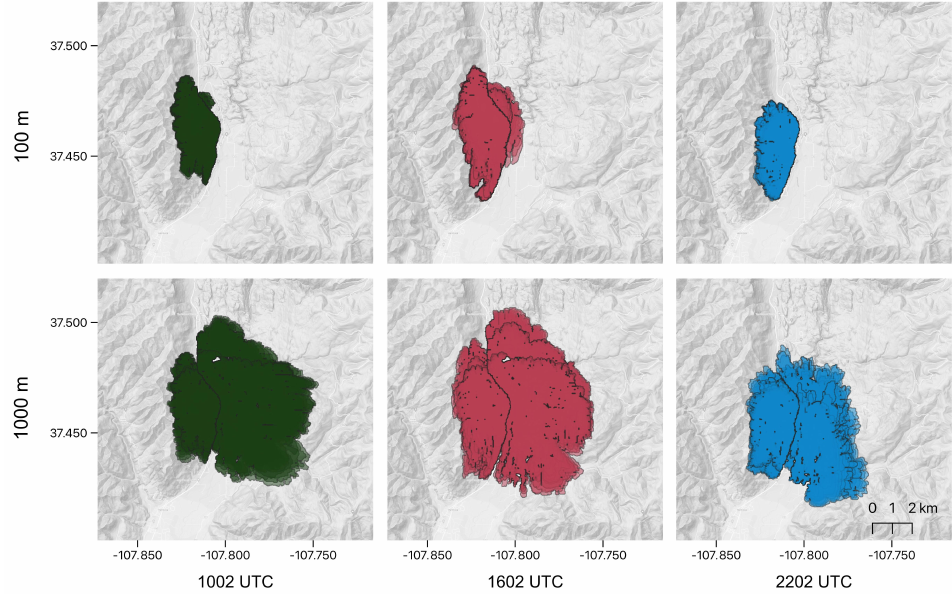
Figure 10. Forecast burned area perimeters for the 416 Fire case study. Simulations initiated at the detection location at the time of detection (magenta, center), six hours before (dark green, left), and six hours after (blue, right) at initiation points 100 m away from the detection points (top) and 1000 m away from the detection point (bottom). Longitude (decimal degrees) and latitude (decimal degrees) showing the location of the 416 Fire are given on the x-axis and y-axis,